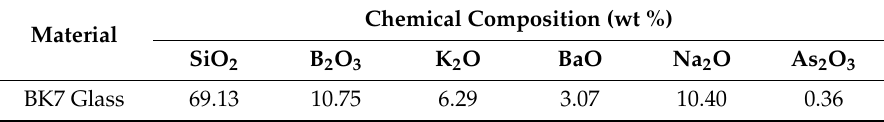
Table 1. Composition of the optical glass BK7 used in the experiments.